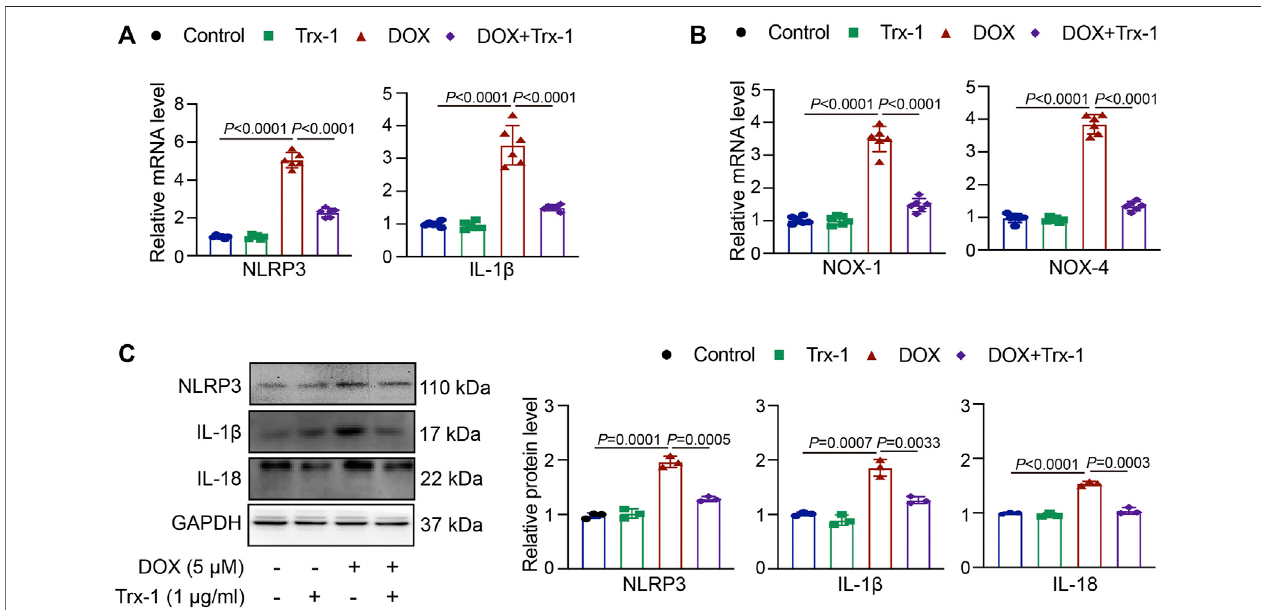
FIGURE 4 | DOX-induced damage in HepG2 cells through Trx-1/NLRP3 signaling. (A) HepG2 cells were pretreated with recombinant Trx-1 (1 μ g/ml) for 4 h afterwards with DOX (5 μ M) for 24 h qPCR analyses of NLRP3 and IL-1 β mRNA levels after application of recombinant Trx-1 in DOX-treated cells ( n = 6); (B) qPCR analyses of NOX-1 and NOX-4 mRNA levels after application of recombinant Trx-1 in DOX-treated cells ( n = 6); (C) Western blot analyses of NLRP3, IL-1 β , and IL-18 protein expressions after application ofrecombinant Trx-1 in DOX-treated cells (left, n = 3), thequanti fi cation ofNLRP3,IL-1 β , and IL-18 protein expressions (right, n =